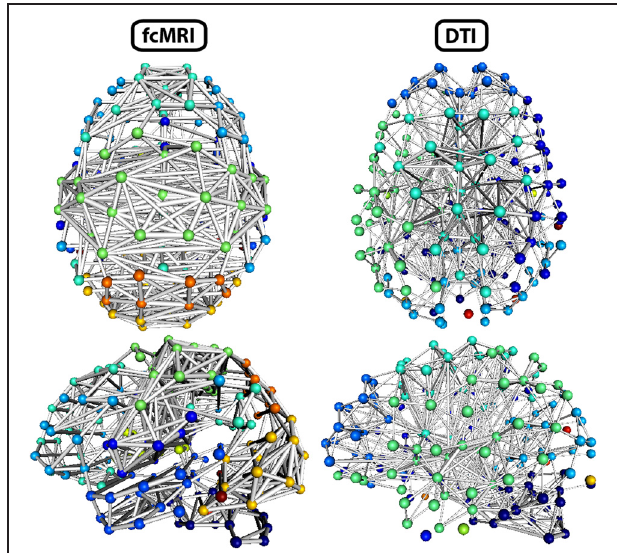
FIGURE 8 | Three-dimensional network renderings of the fcMRI and DTI group average networks, thresholded to show the top 4% of weighted edges based on connection strength. Node colors are based on module membership. The same networks are shown from a top view and a left side view. The fcMRI network shows modules agreeing with known functional networks, longer edge Euclidean lengths, and more bilateral connectivity. The DTI network shows more anatomically confined modules, shorter edge Euclidean lengths, and more local